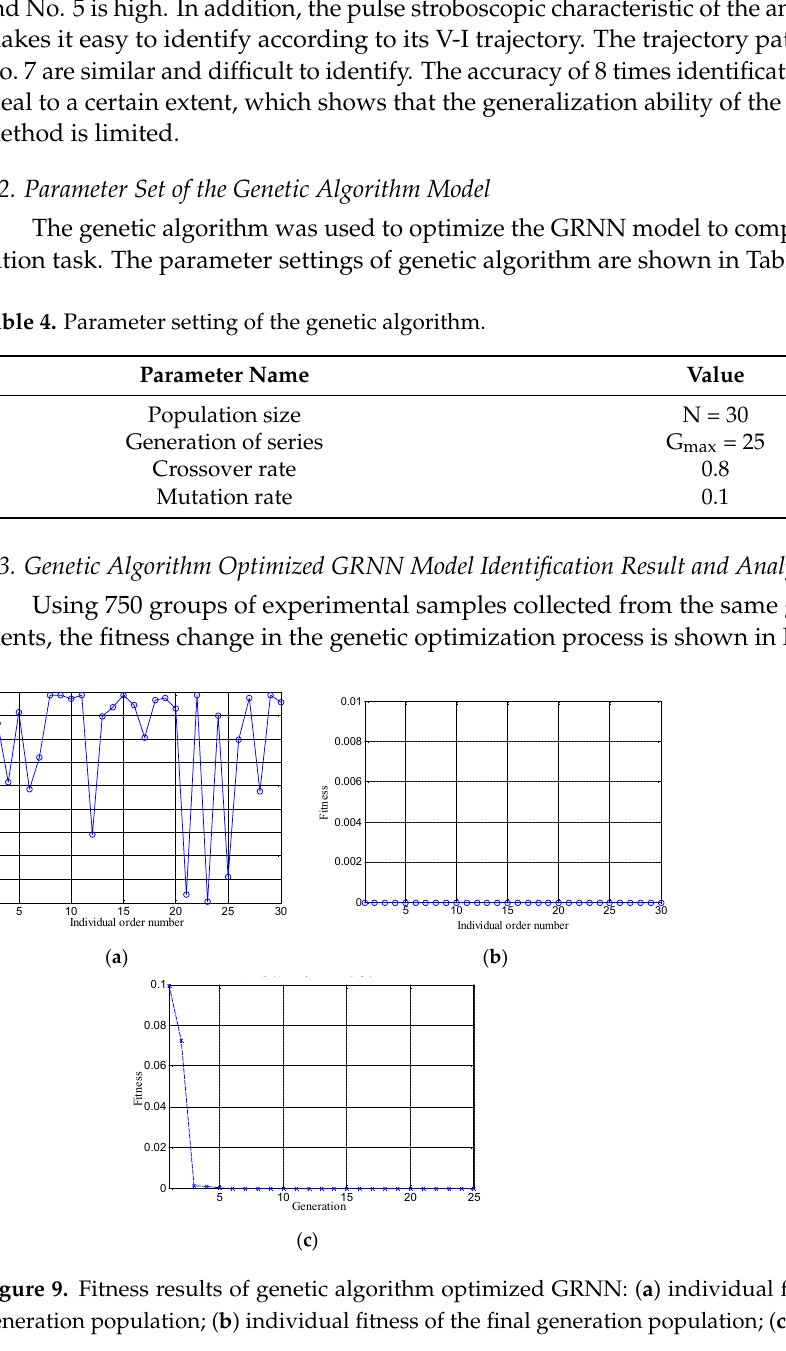
( b ) Figure 10. Identification results and accuracy of genetic algorithm optimized GRNN: ( a ) compari- son between recognition results and actual categories; ( b ) identification accuracy. By analyzing Figure 10a,b, the identification results of all 150 verification samples of No. 1~15 categories are consistent with the actual categories. The recall, precision, and F 1 of identification of all categories reached 100%, which is significantly higher than the